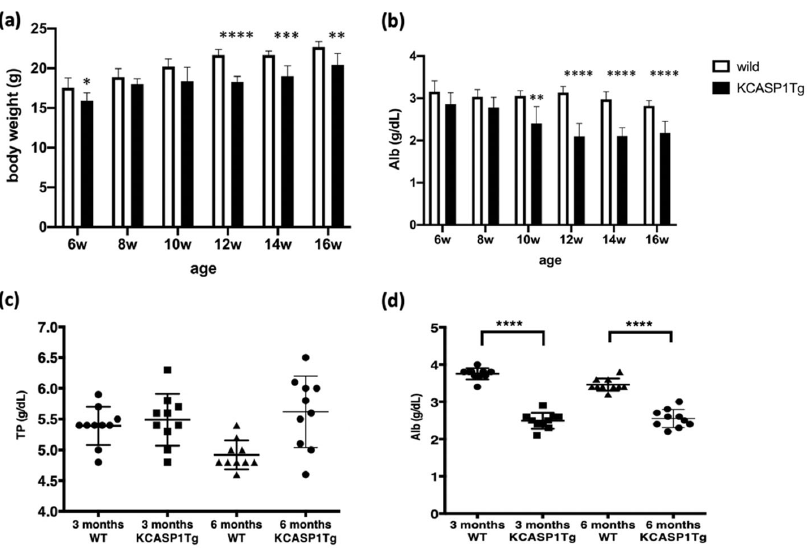
Figure 1. KCASP1Tg mice showed weight loss and hypoalbuminemia. ( a ) Body weight of the KCASP1Tg mice decreased significantly more than that of the WT littermates from 12 weeks of age. ( c ) TP was not significantly different between all the groups; however, Alb decreased from 10 weeks of age in the KCASP1Tg mice ( b , d ). WT; wild ‐ type C57BL/6, KCASP1Tg; K14/caspase ‐ 1 transgenic mouse. Values shown as means ± SDs and statistically significant differences (* p < 0.05, ** p < 0.01, *** p < 0.001, **** p < 0.0001) are indicated.